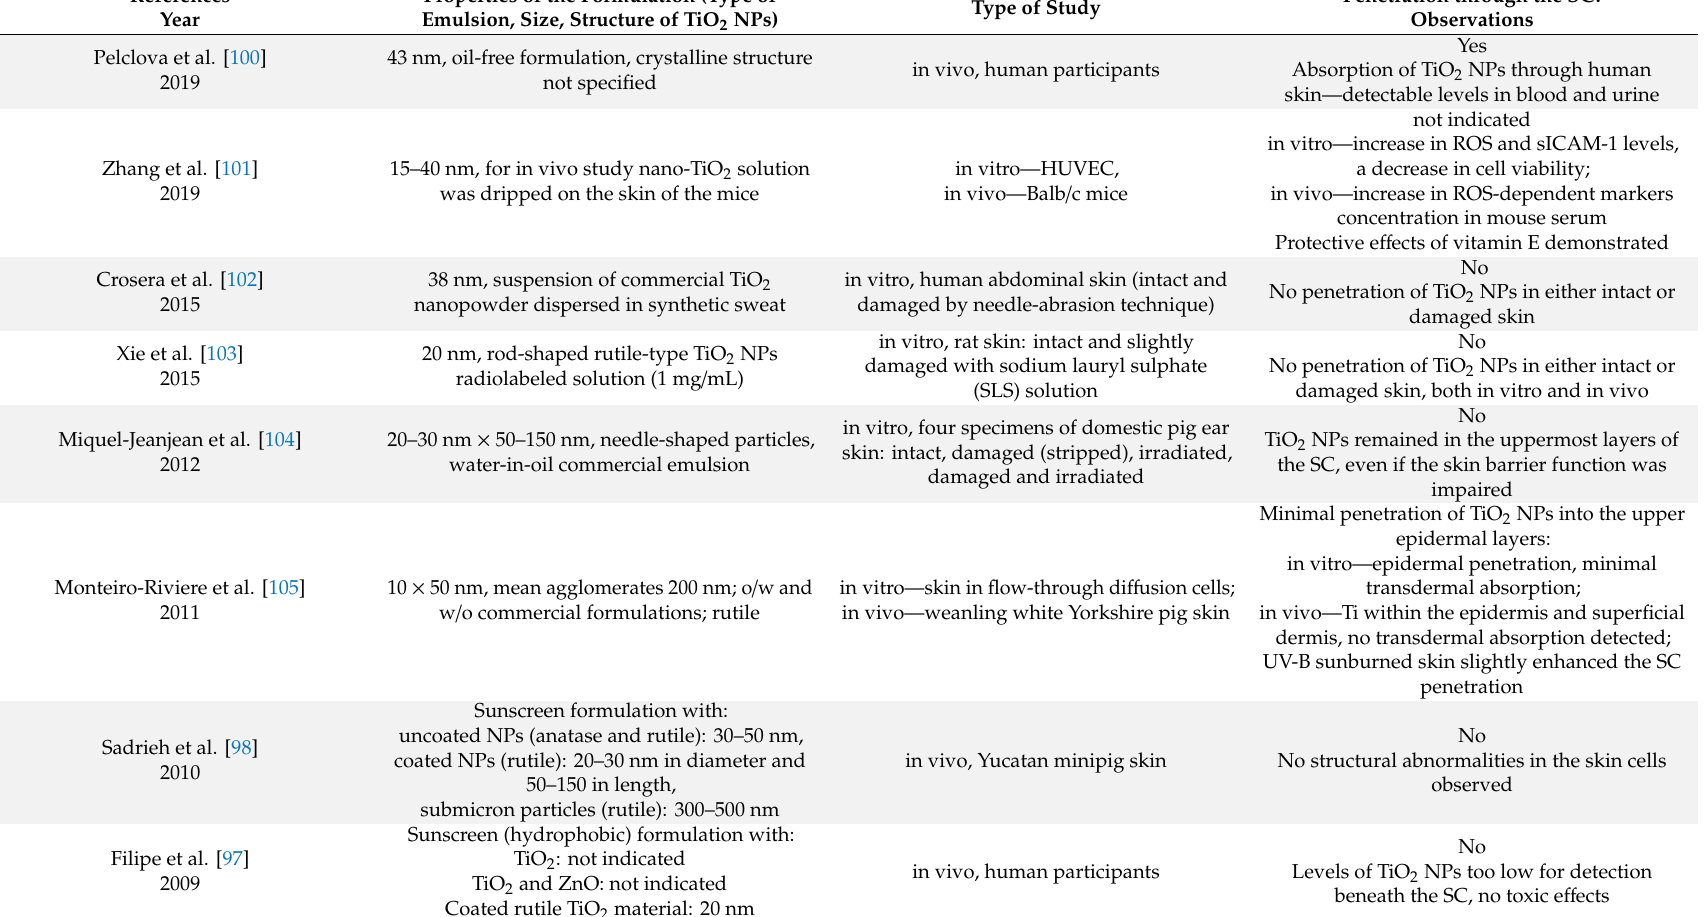
Table 1. Examples of in vitro and in vivo studies to assess dermal exposure to TiO 2 NPs in animals and